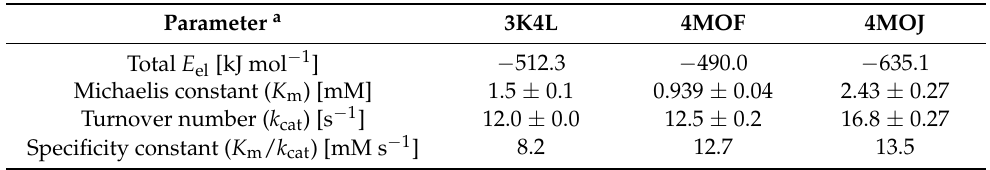
Table 3. Kinetic parameters (with D-glucose as electron donor and O 2 as electron acceptor) of P2Ox mutants compared to the total interaction energy between protein and